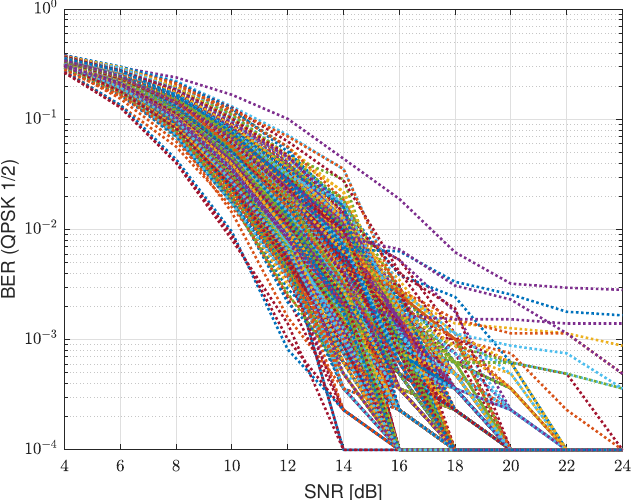
Figure 1. The BER performance for the same MCS system under different simulated UWA channels. In addition, the time-variant of the UWA channel is also not considered in the above expression. In general, the complex marine dynamic process will make the water body non- uniform. Random fluctuations in the sea surface and unevenness in the seabed also affect the propagation of sound waves in the water. The speed of sound will also vary with water depth, temperature, salinity, etc. These factors lead to significant spatial differences and temporal fluctuations in the UWA channel, e.g., large Doppler spread. Furthermore, due to the slow propagation speed of sound waves in water, the mobile UWA communication system will incur long transmission delays, which may make the feedback channel state obsolete. This is unacceptable for the UWA communication system that directly depends on the channel state. To express the dynamic of UWA channels, in this paper, we model the UWA channels as an FSMC with unknown transitional probabilities. Assuming slowly time-varying and quasi-stationary channels, the channel state is stationary during each transmission and is allowed to change in the subsequent transmission according to the Markov model. Let h i denote the channel gain in i -th transmission, which is quantized into G levels. The state transition probabilities P i , j are unknown. Figure 2 shows the schematic diagram of the FSMC, which contains G channel